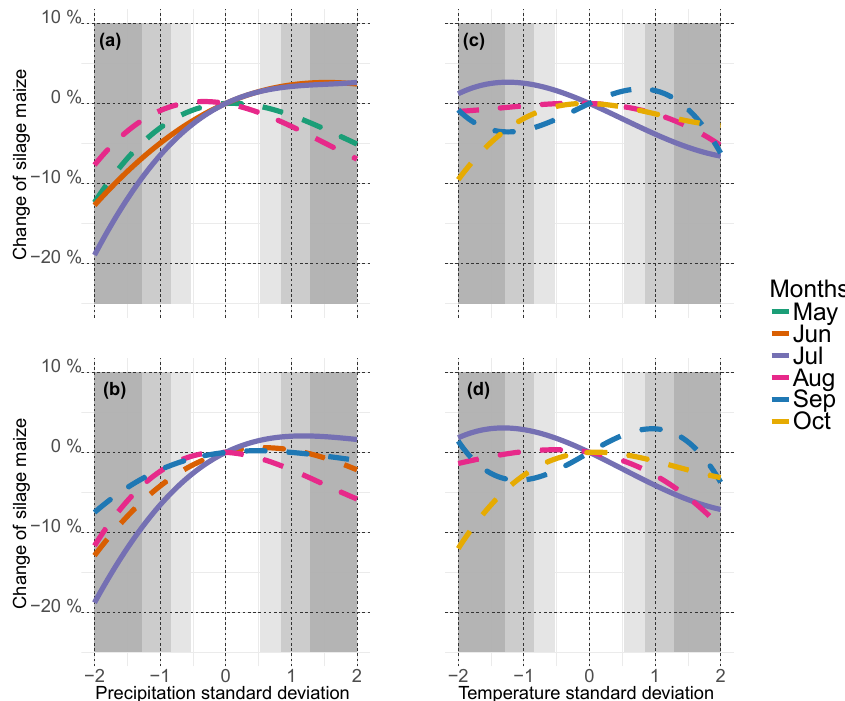
Figure 3. The partial dose-response functions of the meteorological variables are depicted for the range between − 2 and + 2 standard deviations (SD). The upper row represents those models considering SMI, whilst the lower row neglects SMI. A solid line is used for those variables which are significant in both the first- and second-degree polynomials. A dashed line is employed when only one of the first two polynomials is significant. The vertical axis represents the change in silage maize converted into percent. These are approximate values, 3 3 P P β j ( P ikm ) j ) − 1 ) for precipitation (left column) or 100(exp ( γ j ( T ikm ) j ) − 1) for temperature (right either by the formula 100(exp ( j = 1 j = 1 column). Both formulas refer to Eq. (2). Under the assumption that the variables are normally distributed, the range depicted accounts for about 95% of the observations. The dark gray areas denote the interval between the 0.023% ( − 2SD) and the 10% quantiles as well as the 90 and 97.7% ( + 2SD) quantiles. Similar, in medium gray the range between either the 10 and the 20% quantiles or the 80 and 90% quantiles is marked. The light gray quantifies the impact between the between either the 20 and the 30% quantiles or the 70 and 80%